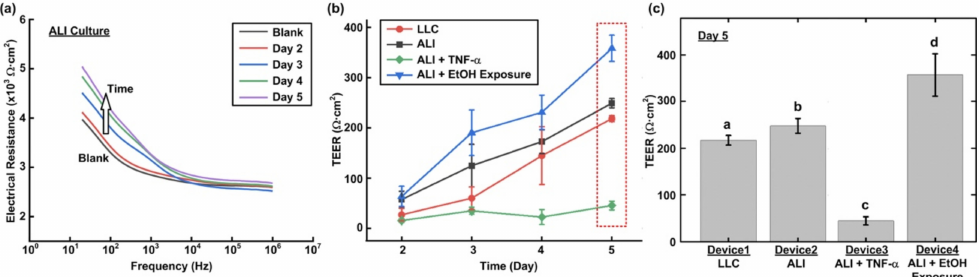
Figure 5. ( a ) Electrical impedance spectrum measured on the epithelium formed in the device at the ALI using the LCR meter in the experiments from Day 2 to 5 and the device after removing the cells by trypsinization at Day 5 (Blank). ( b ) The TEER values calculated from the impedance spectrum measurement results obtained in the cell culture experiments under different conditions from Day 2 to 5 (n = 3). ( c ) Comparison of the TEER values measured on the epithelium cultured under difference conditions at Day 5 (a, b, c, d = p < 0.05, n =